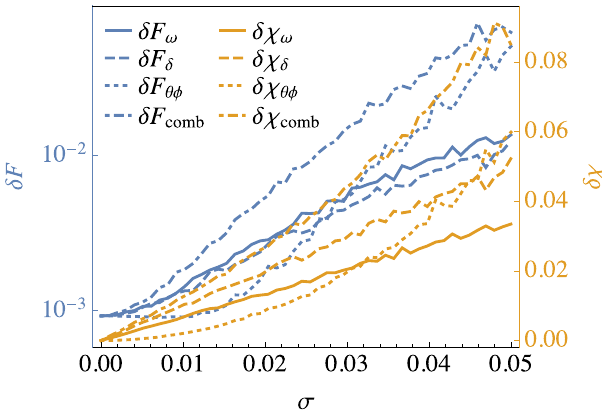
FIG. 7. Tweezer misadjustments. We show the infidelity Eq. (11) (blue) and the over- and under-rotation error Eq. (13) (orange) as a function of the strength of fluctuations σ for three types of misadjustments and for their combination. For each type of misadjustment, the infidelity and the over- and under-rotation error are averaged over 40 realizations. We consider here a chain of 130 ions with 15 buffer ions on each side, and parameters p = 6, (cid:14) ≈ 0.07, and ν 0 =